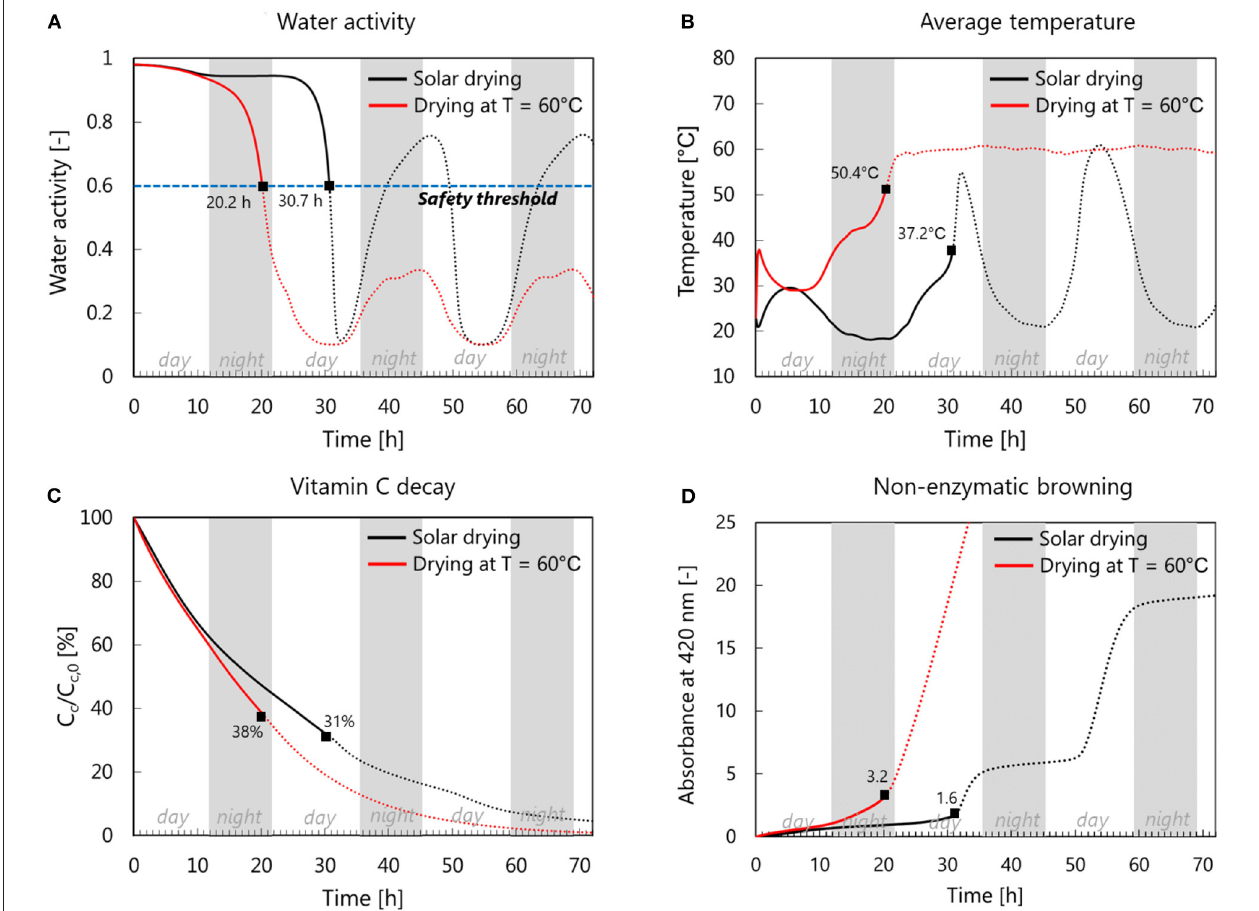
FIGURE 9 | Comparison of volume-averaged (A) water activity and (B) temperature between solar drying and constant-temperature drying at 60 ◦ . Water activity and temperature are used to predict (C) the vitamin C decay and (D) the enzymatic browning absorbance of the apple tissue. Solid lines depict the progression of each parameter before the critical drying time is reached, at a water activity value of 0.6. The square dots show the final value of each parameter at the end of drying